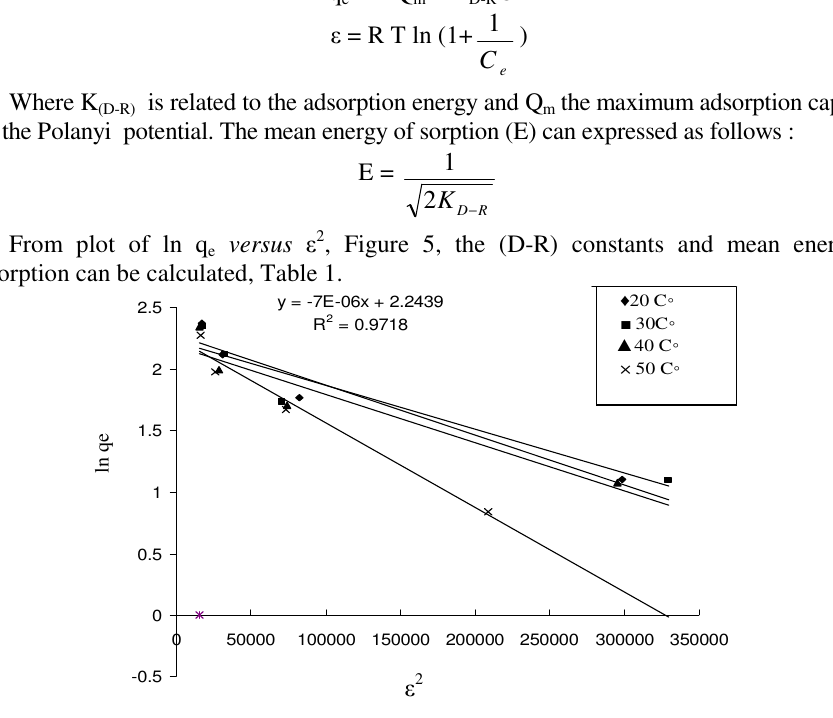
Figure 5. D-R plot for the adsorption of Cr (VI ), 20, 30, 40 and 50 mg / L onto cinnamon 2g/L. Table 1. Comparison of the collections isotherm parameters from Chromium 20, 30, 40 and 50 mg/L adsorption onto